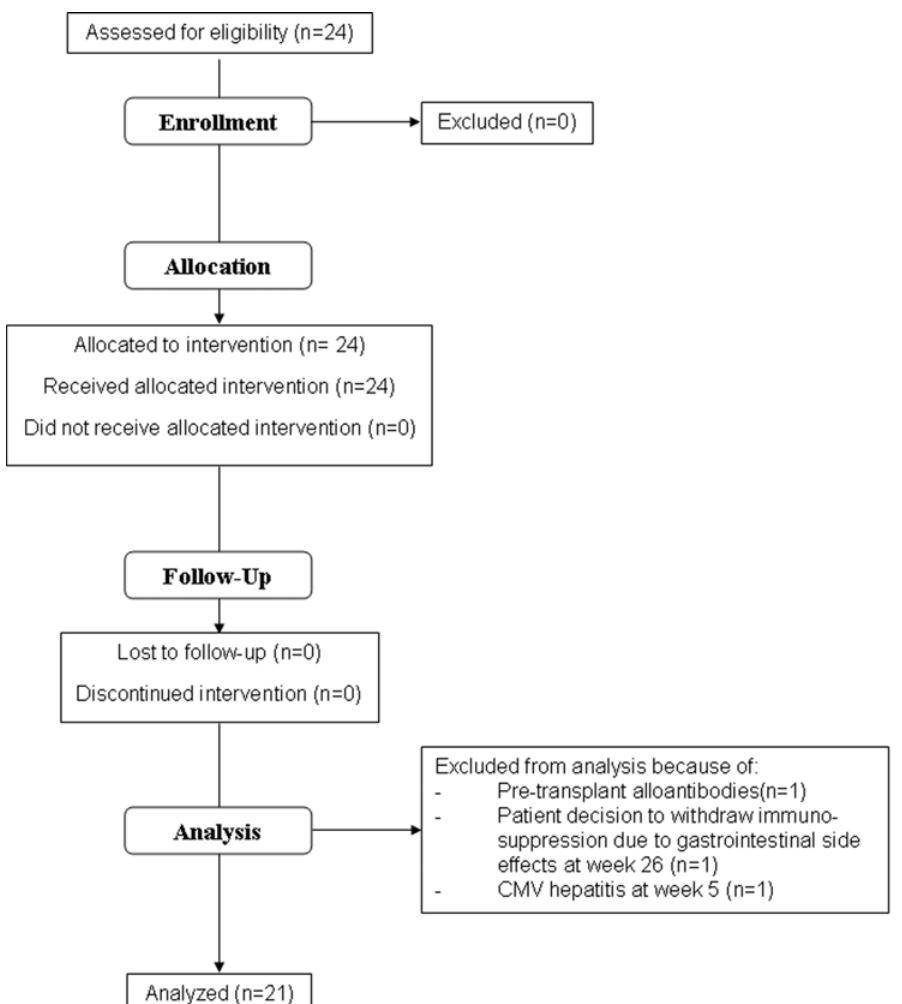
Figure 1. CONSORT-style flowchart of 24 consecutive islet cell transplantation recipients.